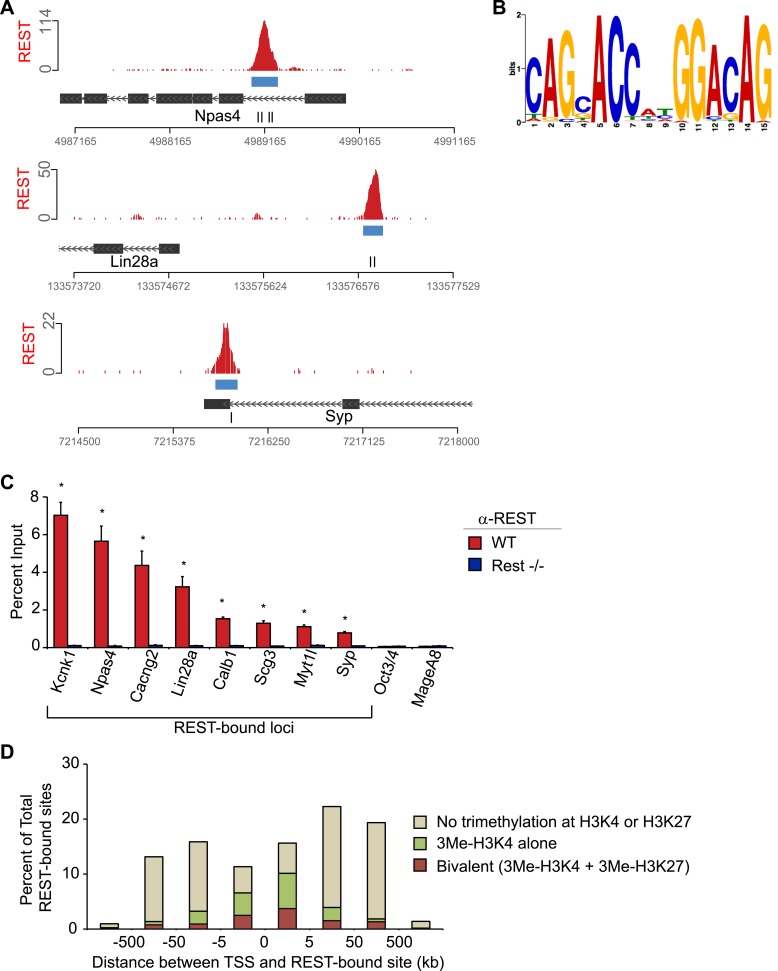
Characteristics of REST-bound loci.(A) Regions with multiple RE1 motifs show a strong
association with REST. REST ChIP-Seq data displayed as sequence tags
aligned to the mouse genome assembly (mm9) viewed in the UCSC genome
browser. Green and red hash marks represent sequences matching the
forward and reverse strands, respectively. Consensus RE1 sequence motifs
are indicated by black hash marks. All views are shown at an equal size
relative to the scale bar. (B) FIMO definition of the RE1
motif was derived from ChIP-seq peaks. (C) Relative
enrichment of REST measured by ChIP-Seq was confirmed by ChIP-qPCR. ChIP
assays were performed using antibody raised against a peptide
corresponding to a fragment of mouse REST in WT (red bars) and
Rest−/− (blue bars) in
ESCs at regions associated with RE1 motifs and regions lacking an RE1
site (Oct4 and MageA8).
(D) REST targets associated with trimethylation of histone
H3K4 or H3K27 enrichment are preferentially localized near gene
promoters. Graph shows the percentage of REST-bound regions that overlap
with domains of the bivalent histone modification pattern consisting of
H3K4me3 and H3K27me3 enrichment (red bars), H3K4me3 enrichment alone
(green bars), or without overlap to either modification (tan bars).